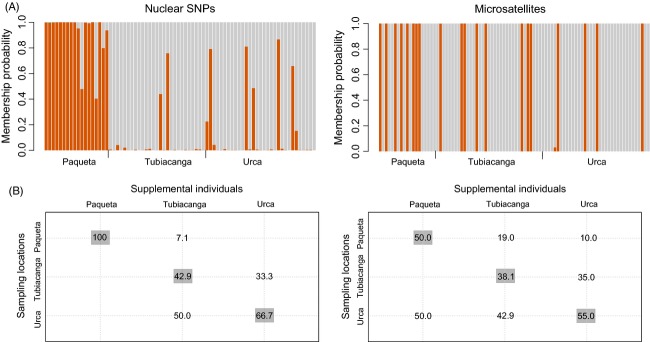
Discriminant analysis of principal components (DAPC). (A) Membership probabilities to two genetic groups for Aedes aegypti individuals, inferred using DAPC of genomewide single nucleotide polymorphism (SNP) and microsatellites; individuals were sampled in Paquetá island, Tubiacanga, and Urca; (B) blind assignment success for supplemental individuals to the three sampling locations; diagonal values in darker boxes represent assignment to the original sampling location (‘correct reassignment’).